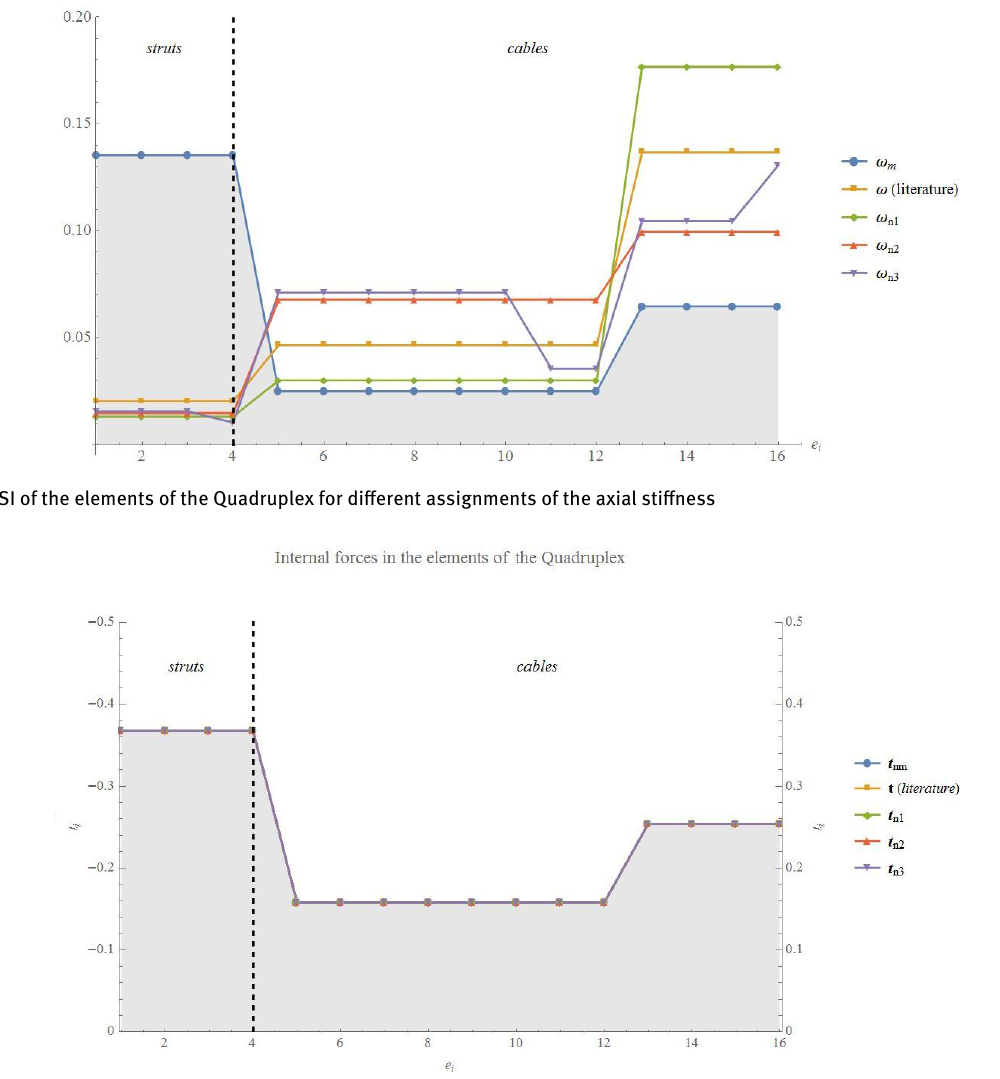
Figure 3: Internal forces in the elements of the Quadruplex as the axial stiffness of the elements